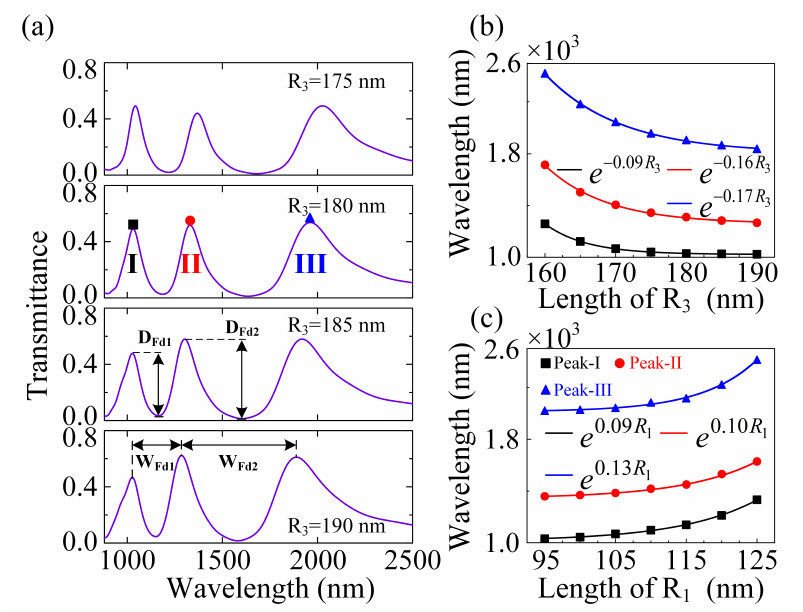
Figure 4. DFRs-based plasmonic sensing with in-plane mirror symmetry σ x . ( a ) The transmittance spectra for the hybrid RMM with different outer radii ( R 3 ) of the CRA unit cells, where the incident light is polarized along the X-axis. ( b ) The resonance center wavelengths of the three peaks of the plasmonic DFRs in the hybrid RMM as three different exponential decrease functions of the outer radius ( R 3 ) of the CRA unit cells. ( c ) The resonance center wavelengths of the three peaks of the plasmonic DFRs in the hybrid RMM as three different exponential increase functions of the inner radius ( R 1 ) of the CSA unit cells. The other parameters are the same as Figure